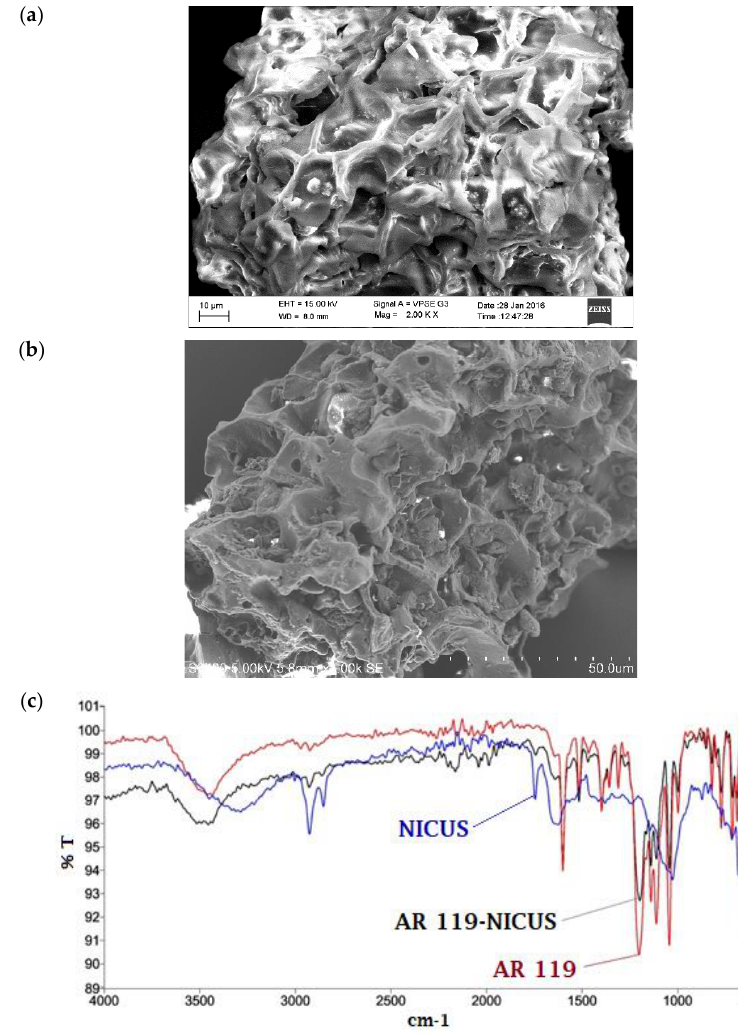
Figure 6. ( a ) SEM image of NICUS. ( b ) SEM image of AR119-NICUS. ( c ) FTIR spectra of AR119 dye, NICUS and AR119 dye adsorbed onto NICUS.